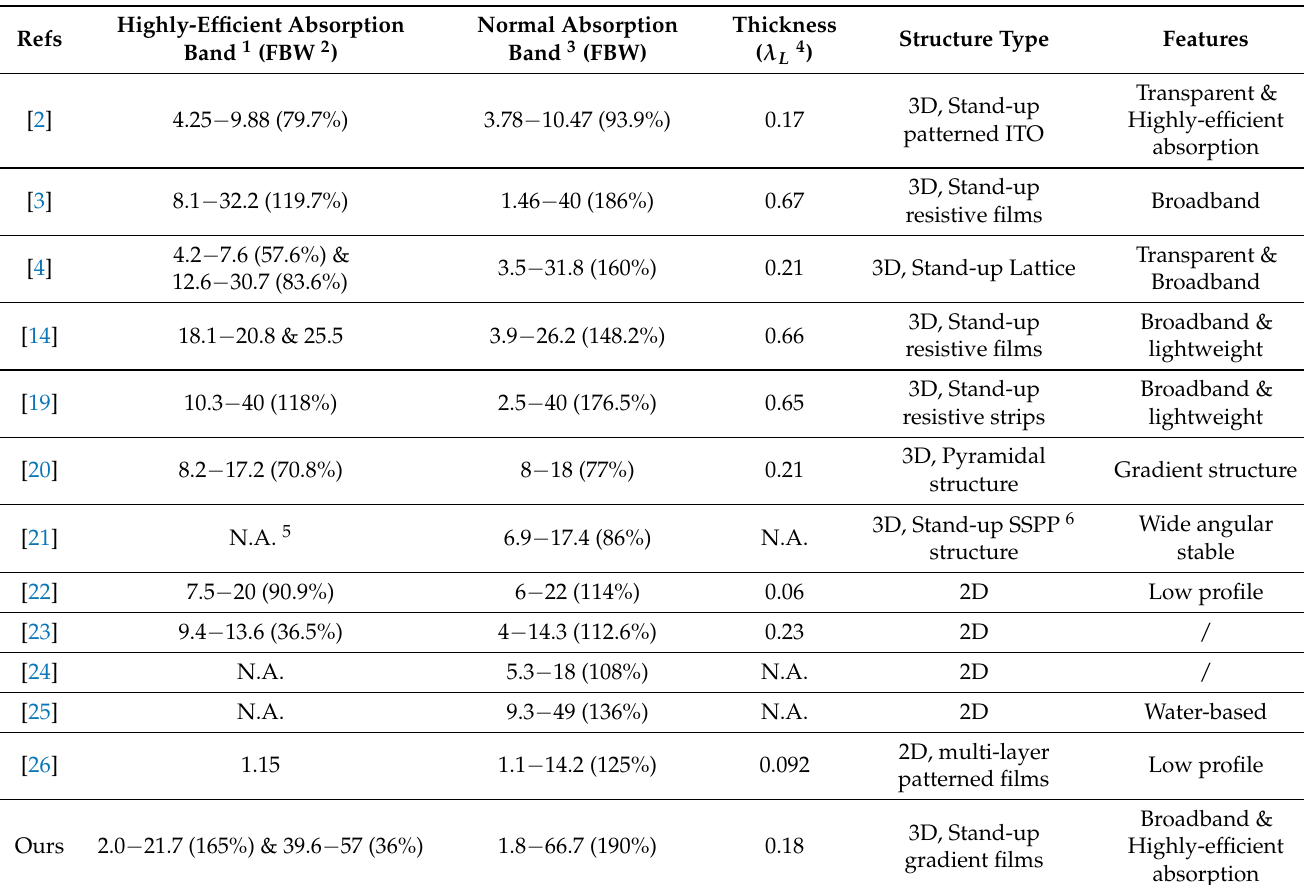
Table 3. Performance comparison table between the proposed MMA and other reported